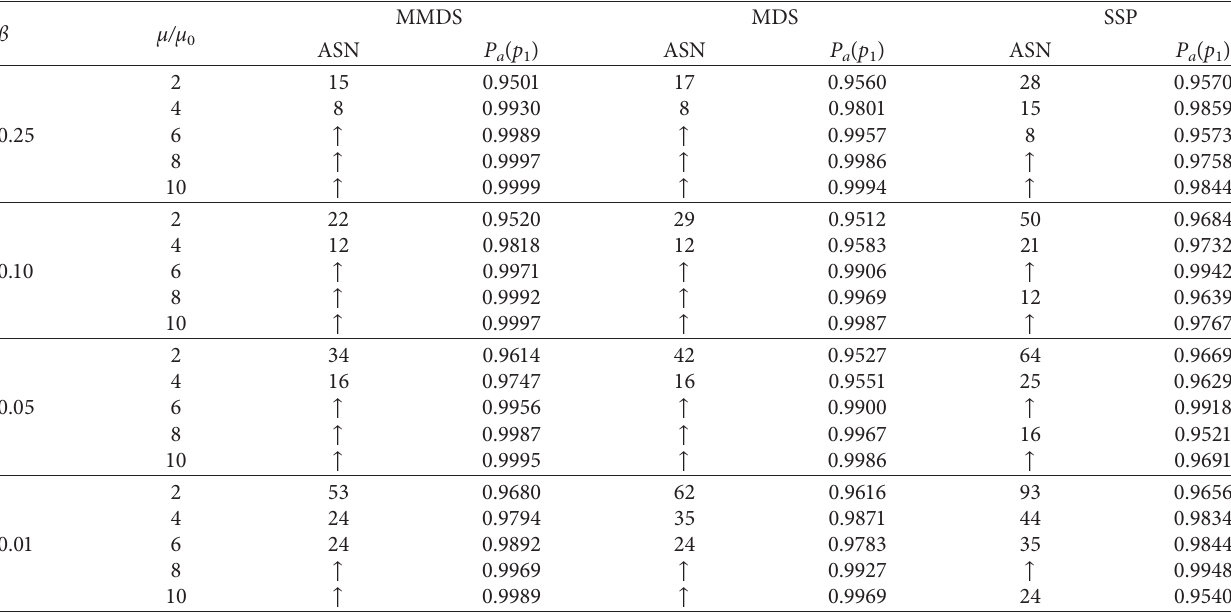
Table 7: ASN of the proposed modified MDS (MMDS) plan, MDS sampling plan, and SSP for assuring Weibull distributed mean life with shape parameters δ � 2 and a �